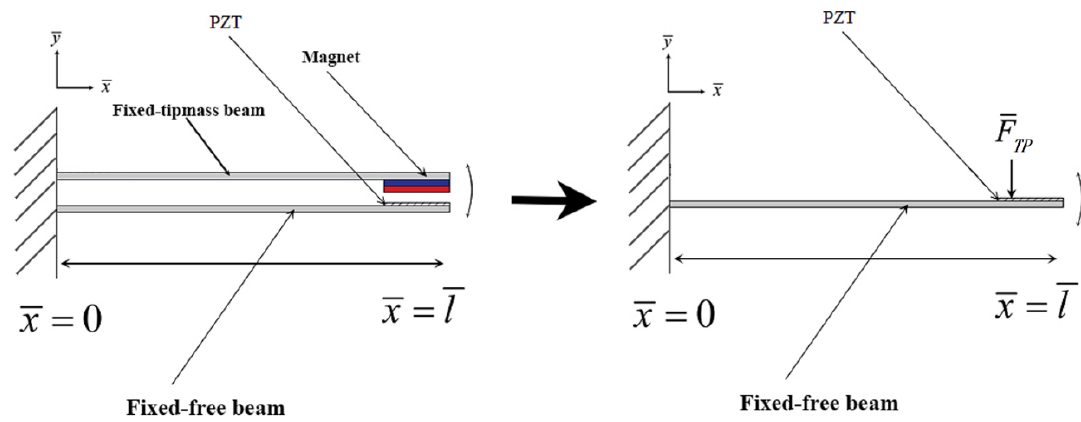
Figure 2. Extended System Design.